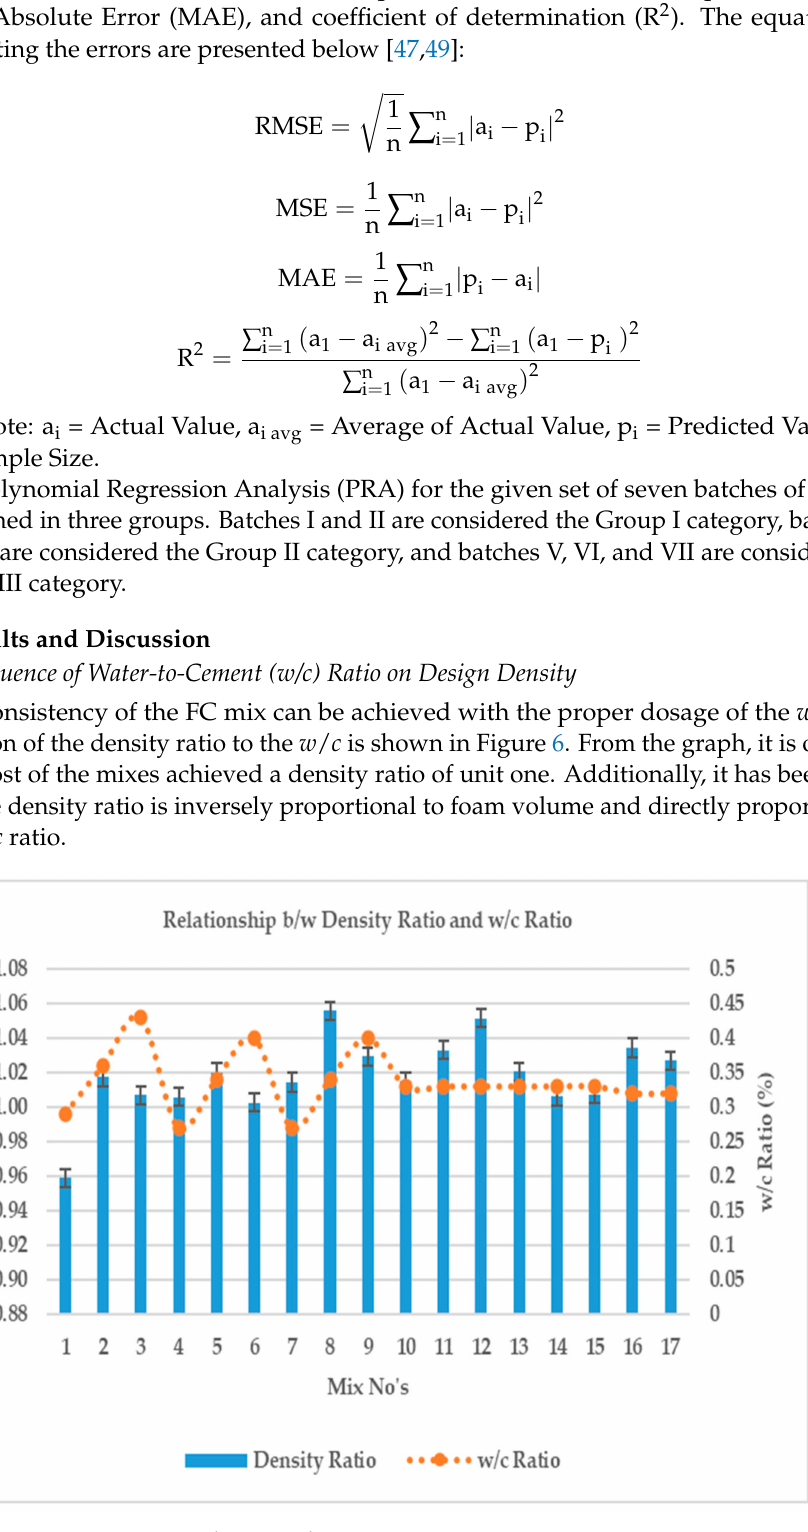
Figure 6. Density Ratio vs. w / c Ratio of